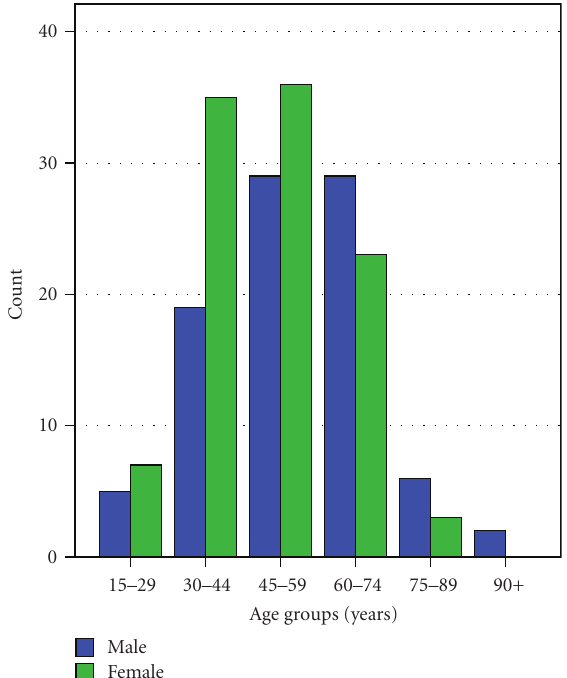
Figure 1: Age of the patients at the time of first melanoma